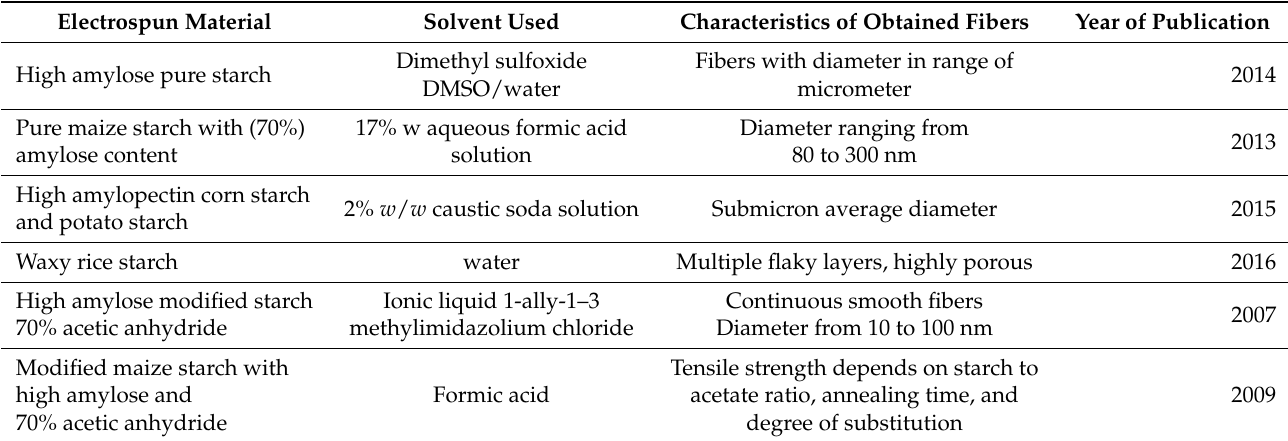
Figure 5. Schematic illustration of electrospinning setup: syringe (pump) (1), polymer solution (2), needle (3), liquid jet (4 and 6a), Taylor cone (5), fibers (6b), circuit (7), collector (8a) and drum collector (8b). Table 3. Electrospun fibers from starch